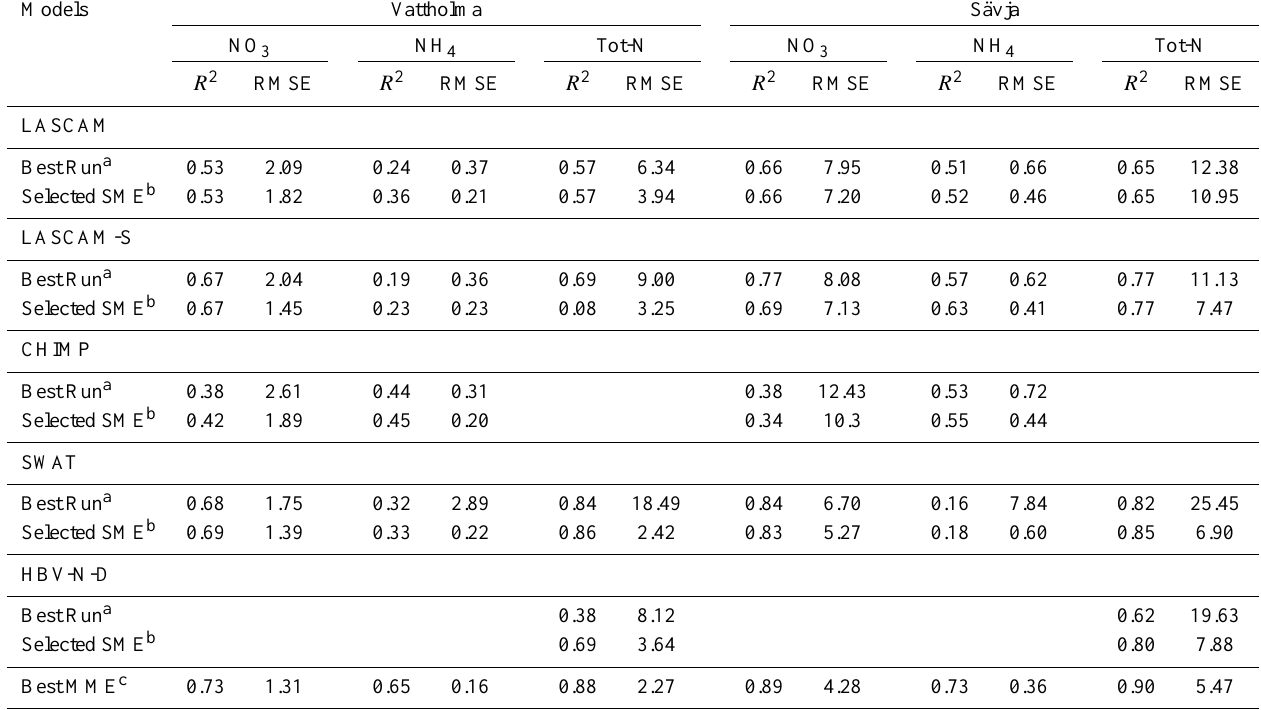
Table 4. Nitrogen results summary between 1 January 2000 and 31 December 2004. RMSE is expressed in g/had − 1 .